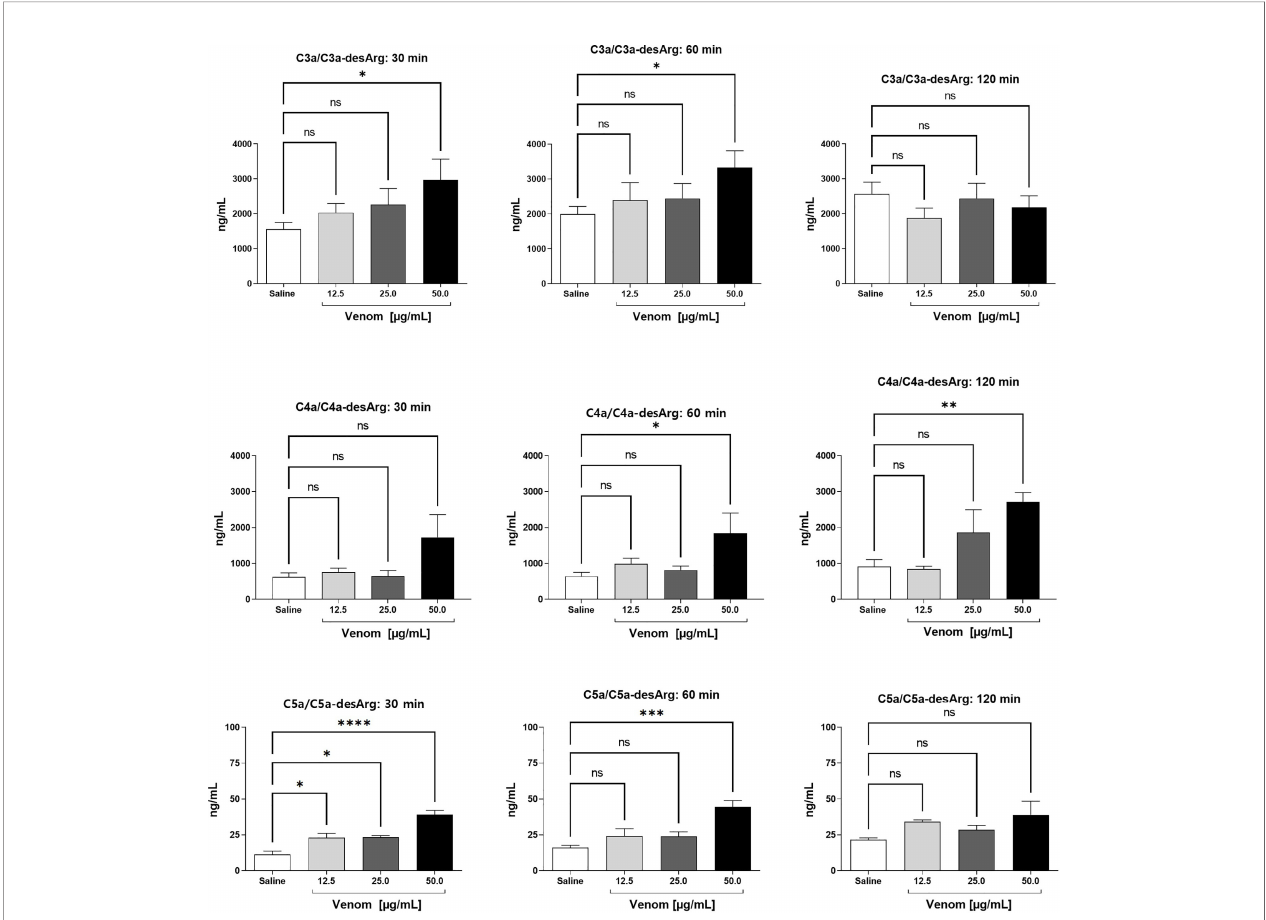
FIGURE 1 | C3a/C3a-desArg, C4a/C4a-desArg and C5a/C5adesArg levels in human plasma after treatment with B. jararaca venom. Human blood samples containing the peptide GPRP (8 mg/mL) were incubated with increasing concentrations of B. jararaca venom or sterile saline solution for 30, 60 and 120 minutes at 37°C. After plasma collection and dilution, the production of anaphylatoxins C3a/C3a-desArg (1:5000), C4a/C4a-desArg (1:5000) and C5a/C5a-desArg (1:1000) was evaluated by cytometric bead array (CBA). The results are presented as the mean ± SEM from three independent tests. ns, not signi fi cant; * p ≤ 0.05, ** p ≤ 0.005, *** p ≤ 0.0005, **** p <